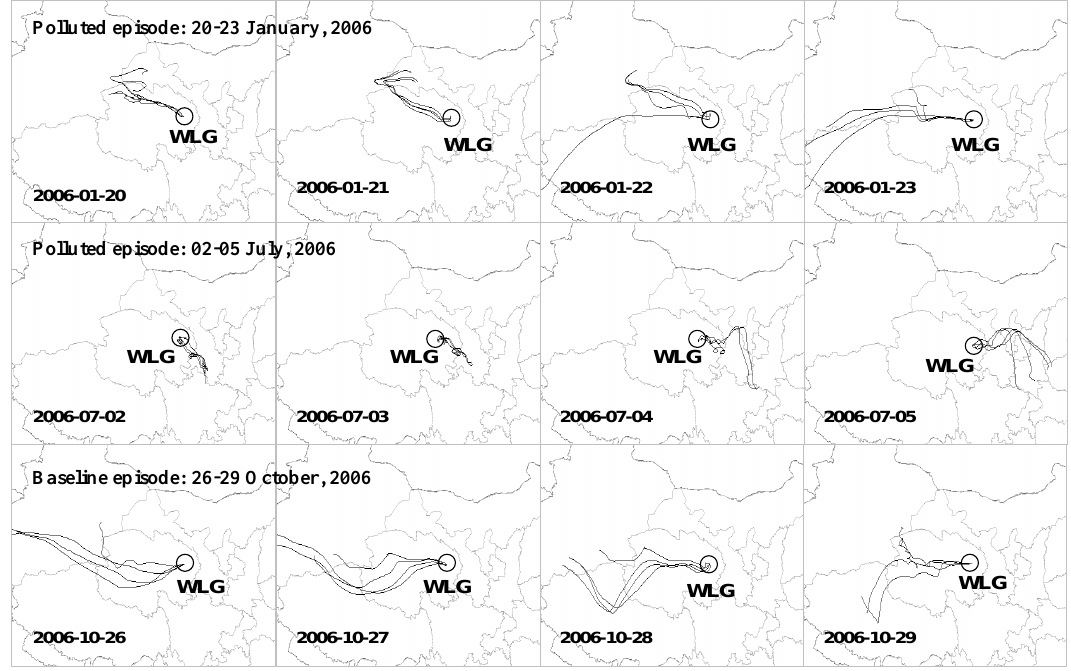
Fig. 8. Trajectories (+500m above ground) for selected days (5-d back trajectories at 00:00, 06:00, 12:00 and 18:00UTC), open circle is the location of WLG; black cross is the location of Geermu city.